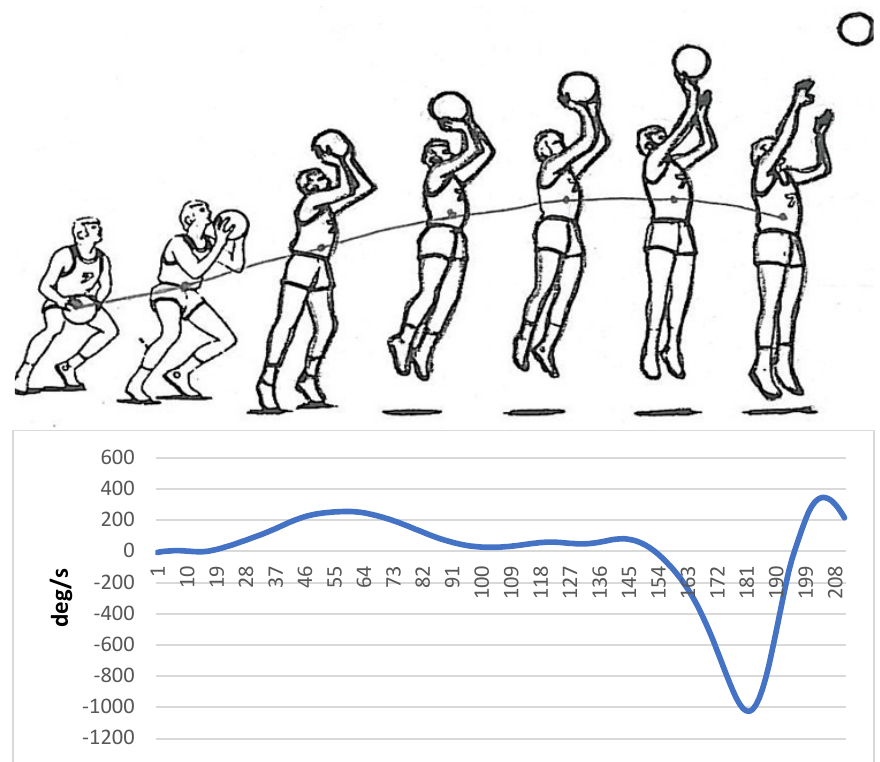
Figure 1. Angular velocity of the elbow joint regarding the different stages of the basketball jump shot (Horizontal axis: time frame, Vertical axis: angular velocity ( ω )).